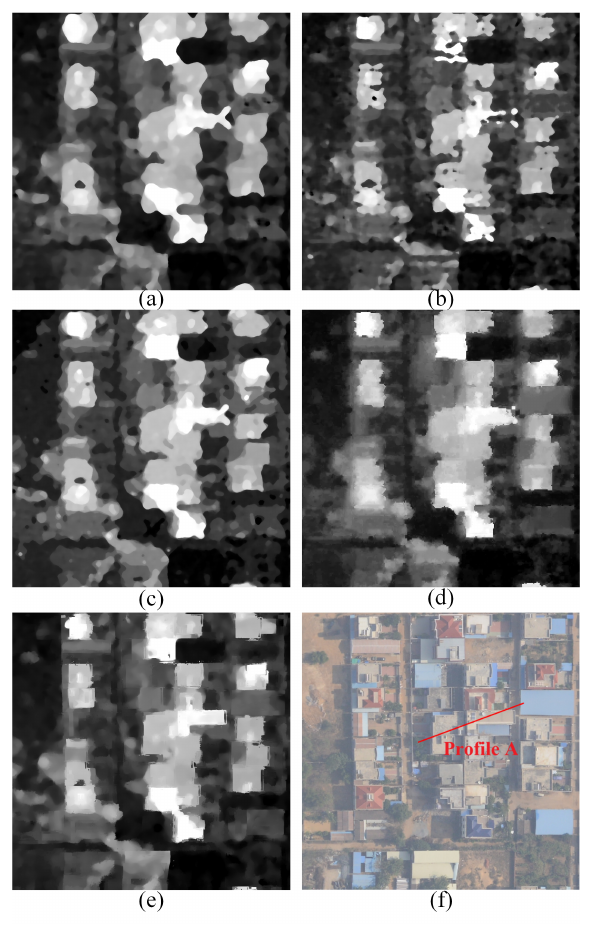
Figure 8. Disparity map generated by (a) COSI-Corr with a larger window size, (b) COSI-Corr with a smaller window size, (c) hierarchical and adaptive framework with fixed variation (HAFV), (d) MicMac and (e) the proposed scheme. (f) Original left image.